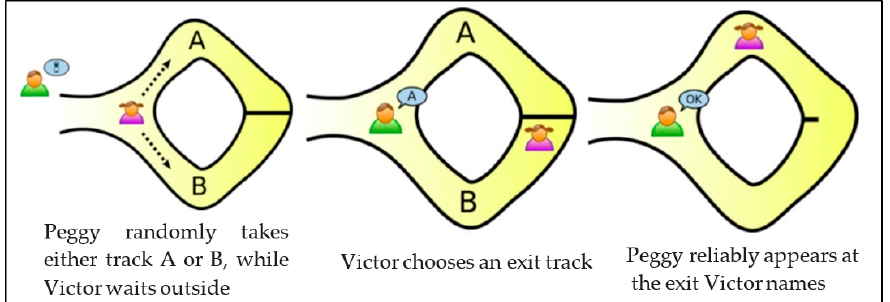
Figure 2. Zero Knowledge protocol example [50].